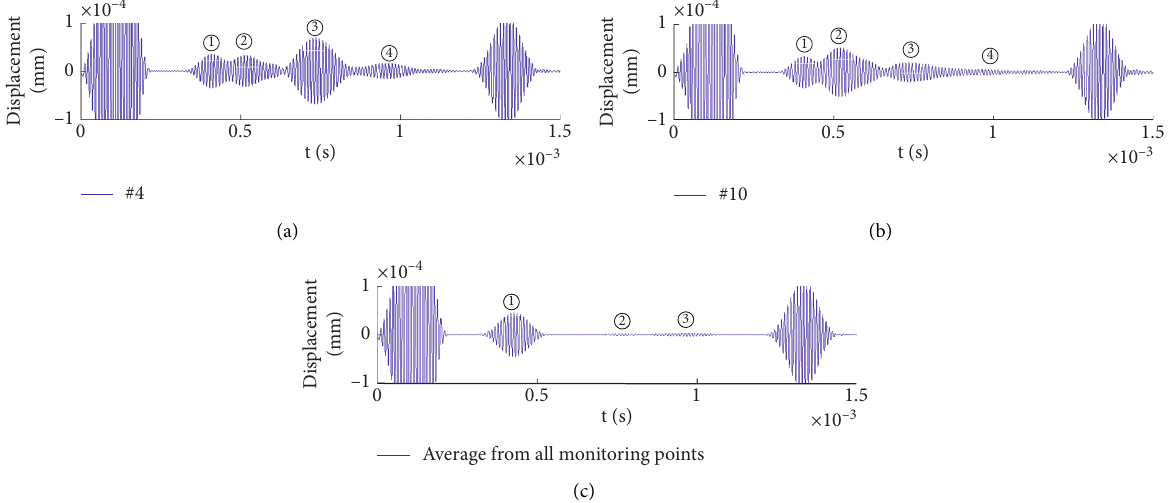
Figure 12: Time domain waveforms received from a hexagonal pipe with a through-hole damage located in center of the top plane: (a) received from the plane monitoring point #4; (b) received from the edge monitoring point #10; and (c) average from all 12 monitoring points.